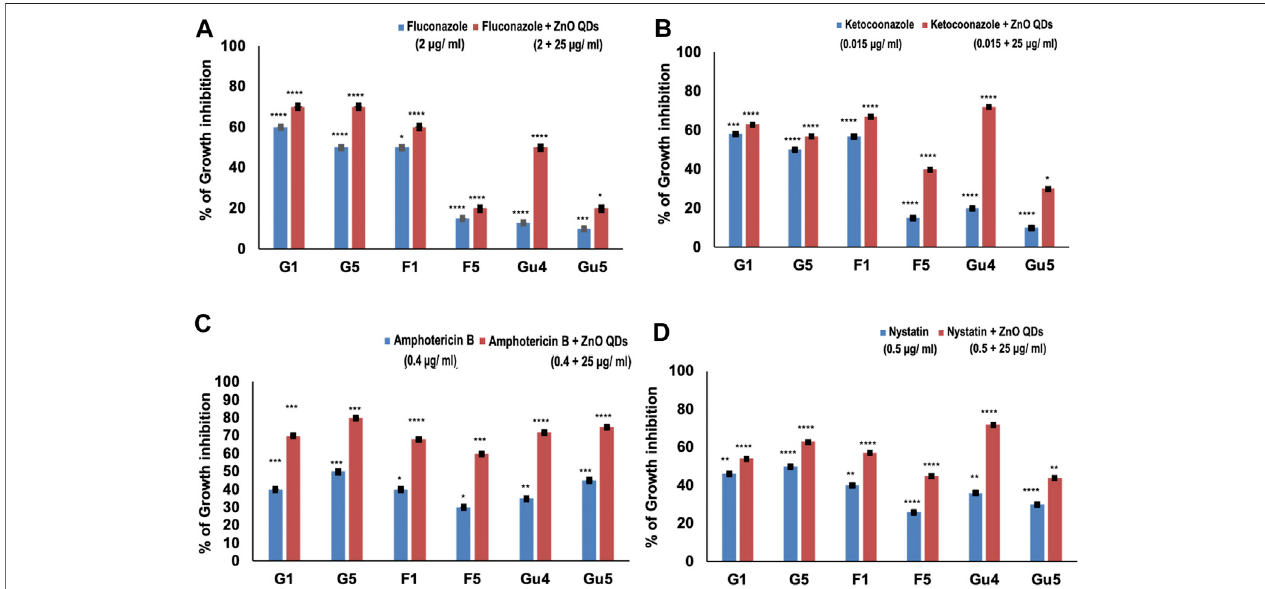
FIGURE4| |PercentageofgrowthinhibitioninC.albicansstrains(isogenicmatchedpairsG1andG5,F1andF5,andGU4andGU5)inthepresenceofbothdrugs and ZnO QDs as compared to growth control (absence of drugs and ZnO QDs): (A) Fluconazole + ZnO QDs; (B) Ketoconazole + ZnO QDs; (C) Amphotericin B + ZnO QDs; (D) Nystatin+ZnOQDs.Thevaluesaremean ± SDofthreeindependentsetsofexperiments.****represents p < 0.0001,***represents p < 0.0002,**represents p < 0.0046, * represents p < 0.0408, calculated with respect to growth